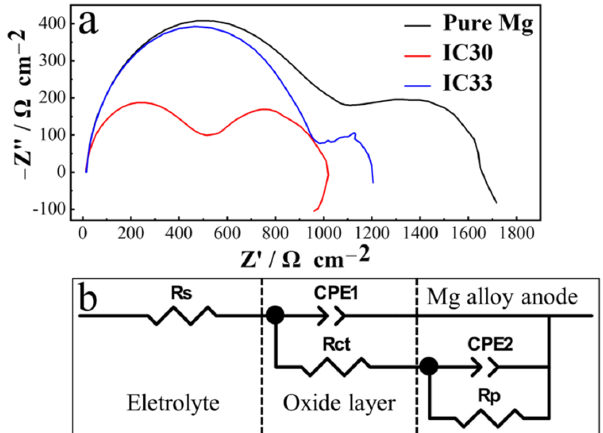
Figure 9. ( a ) Electrochemical impedance spectroscopy (EIS) of Mg-based anode in 3.5% NaCl solution; ( b ) equivalent circuit diagram. Table 4. EIS-simulated values of alloys.